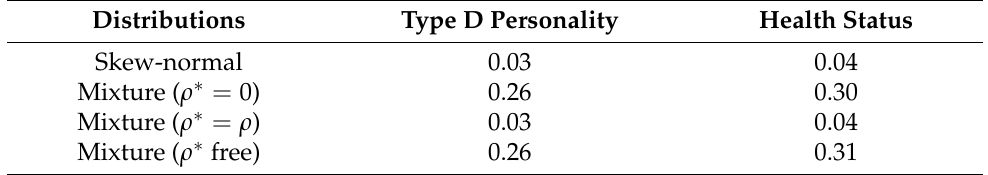
Table 4. The average absolute differences in ρ